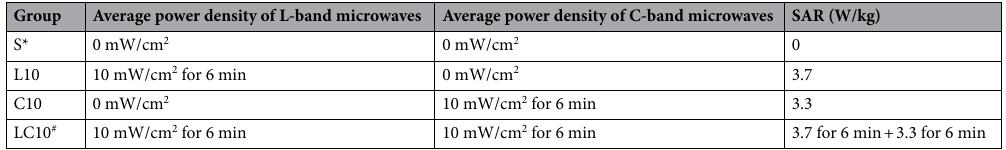
Table 1. Groups and microwave radiation. *The rats in the sham radiation group were placed in polypropylene cages for 6 min # The rats in the LC10 groups were first irradiated with L-band microwave radiation for 6 min and then immediately irradiated with C-band microwave radiation for 6